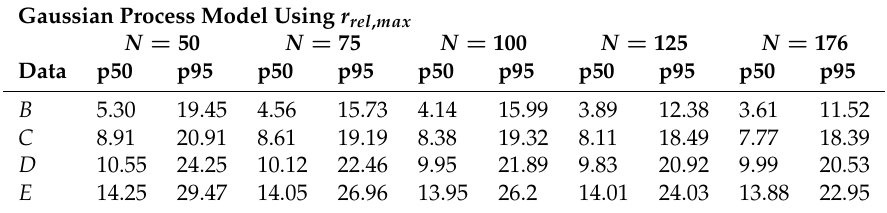
Table 6. The p50 and p95 percentiles of the error expressed in (cm) for the Gaussian process model. Gaussian Process Model Using r rel , max N = 50 N =